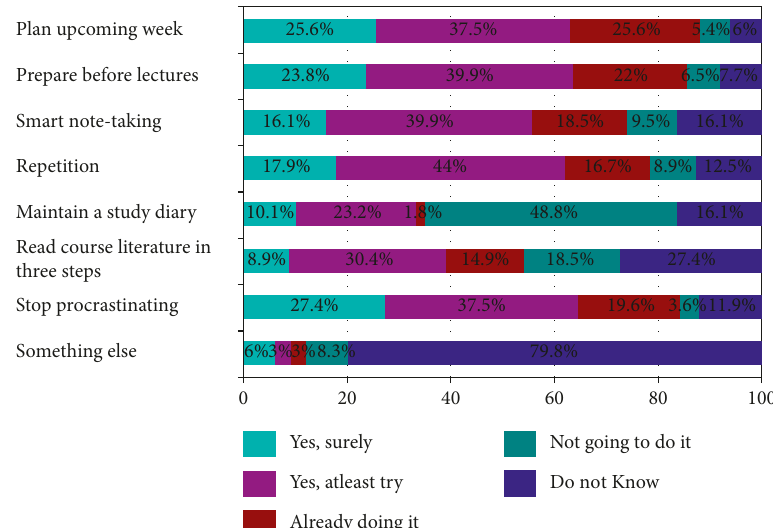
Figure 2: Results from the question “After informing yourself and reflecting about study techniques for this seminar, which study skills or study habits do you plan to change?” in the prequestionnaire. Table 2: Results from the first question of the postquestionnaire, after trying the study skills. Did you plan to ... Already doing it (%) Will not do it